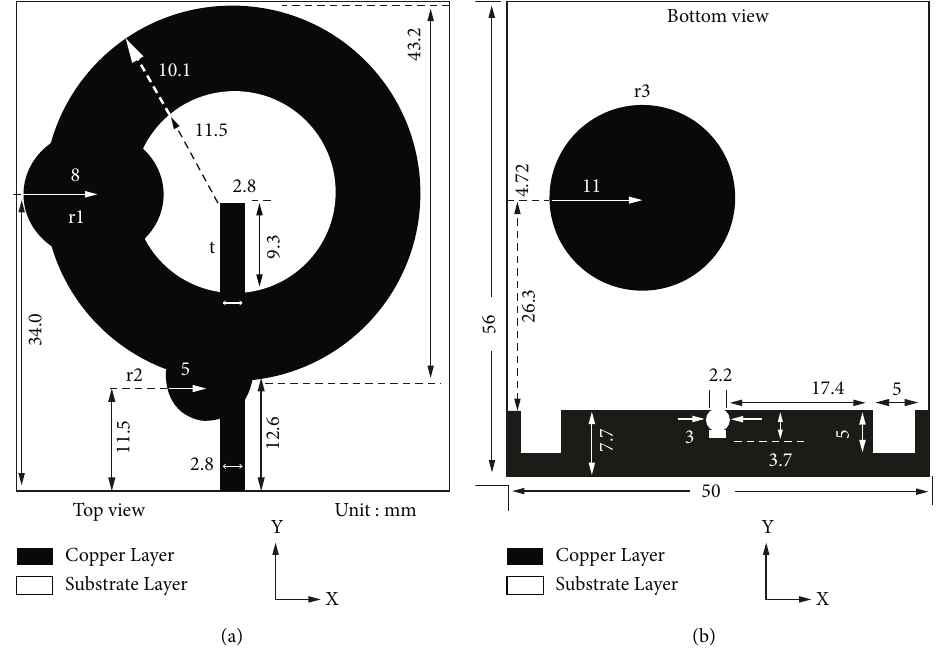
Figure 2: Proposed wideband antenna design architecture: (a) top view and (b) bottom